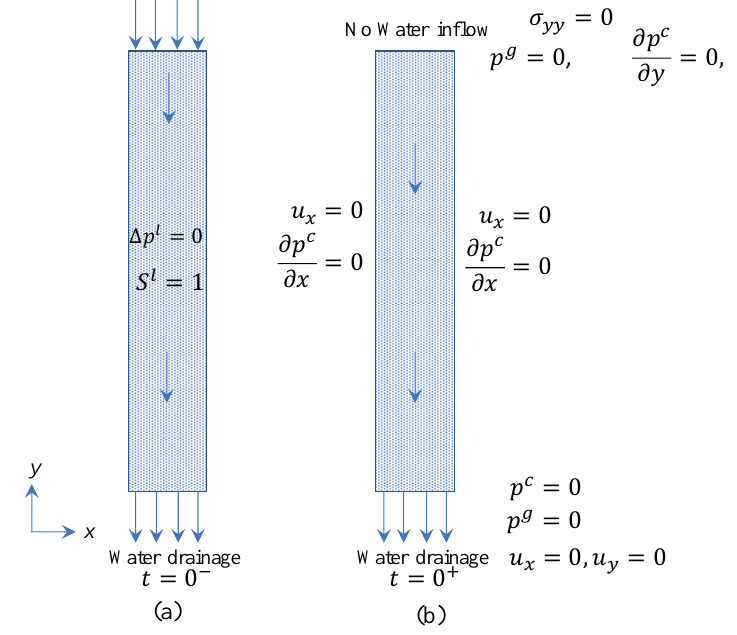
− , and ( b ) t = 0 + (Note: not in